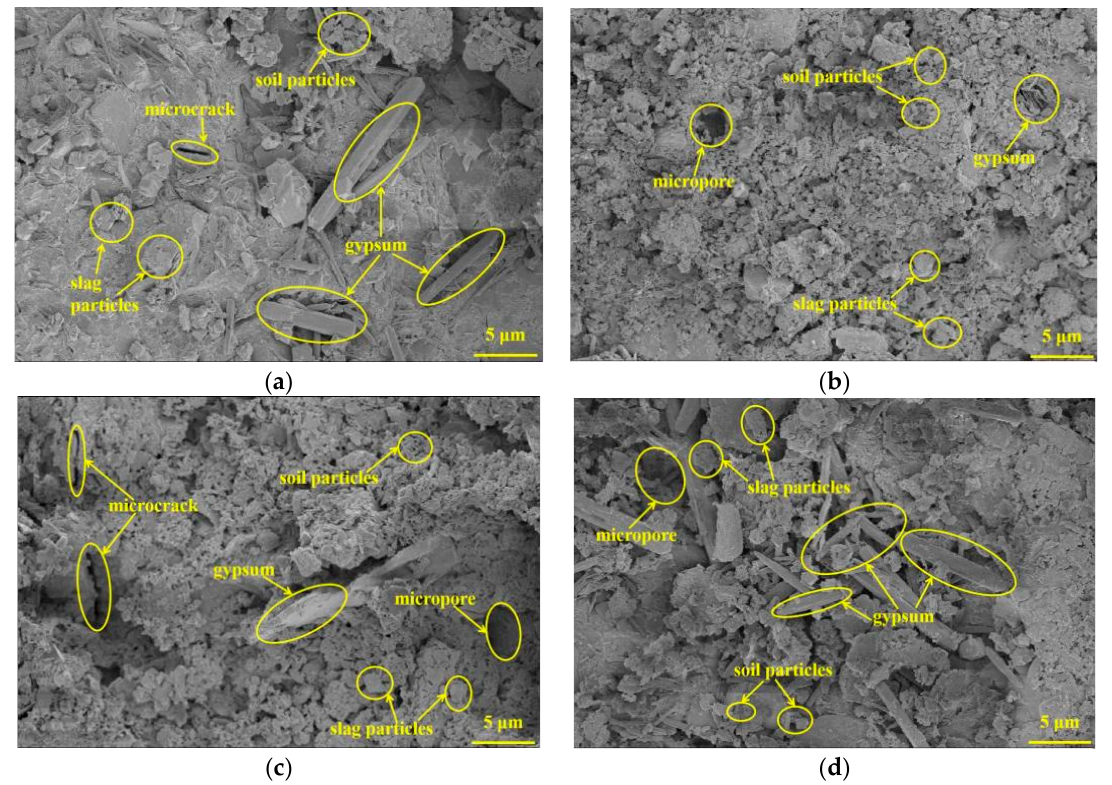
Figure 12. SEM analysis of SF-GSSS immersed in MgSO 4 solution for 60 days: ( a ) S10F0; ( b ) S9F1; ( c ) S8F2; and ( d ) S7F3.